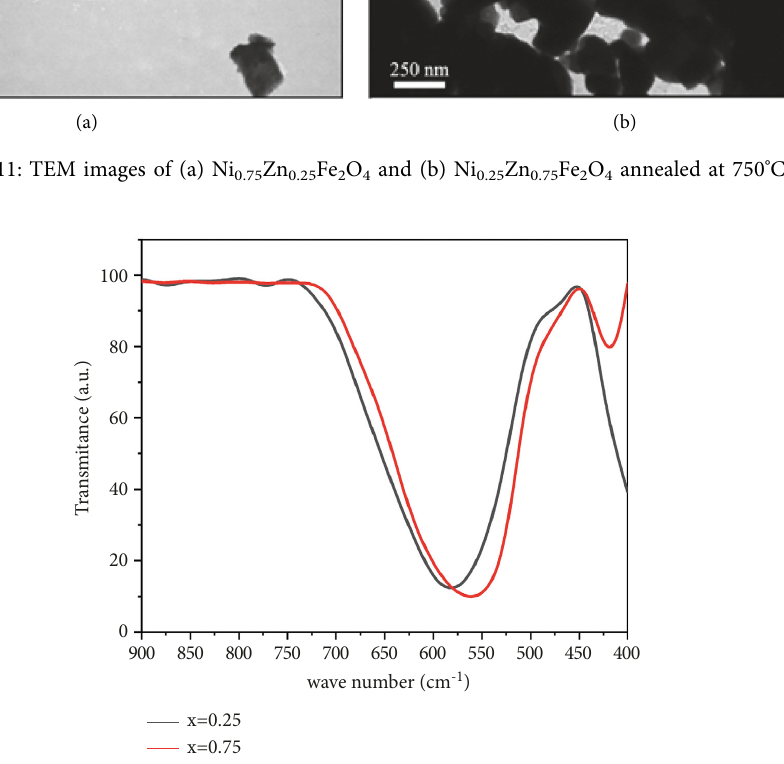
Figure 12: FTIR spectra of Ni ° C with different Zn concentrations: x � 0.25 and 0.75. 1-x Zn x Fe 2 O 4 annealed at 750